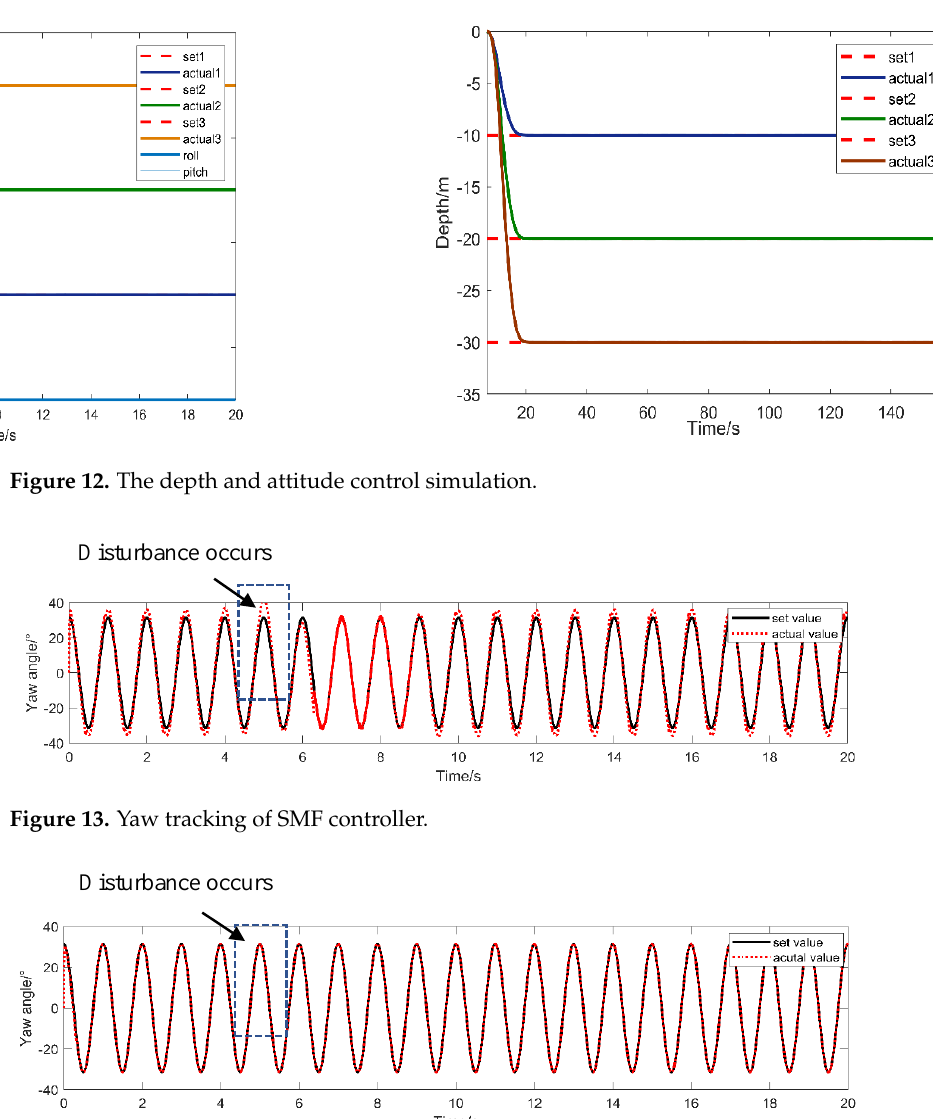
Figure 15. SMF controller output.